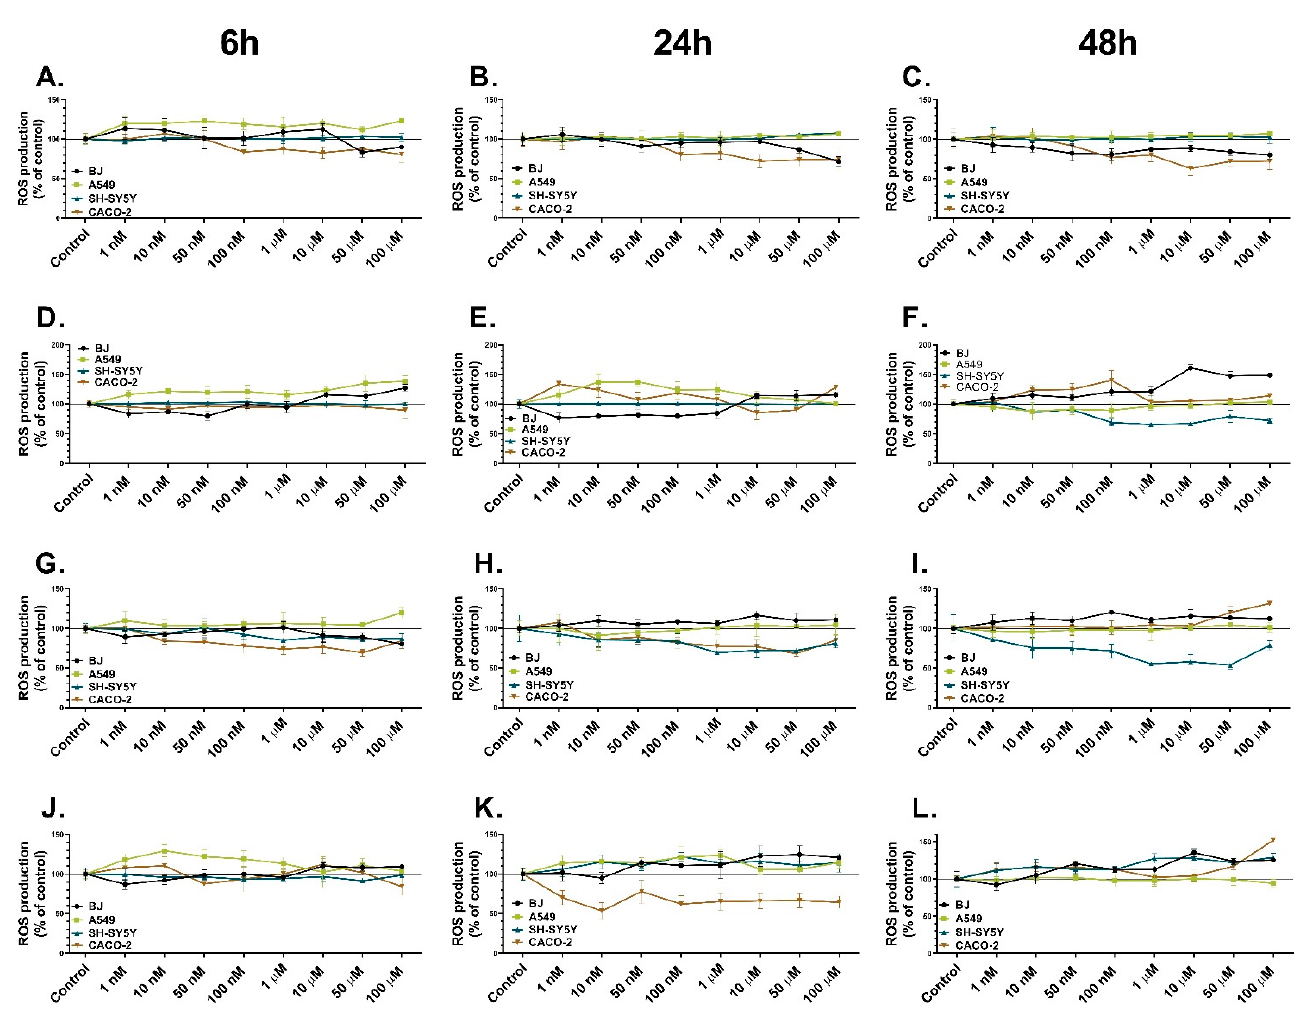
Figure 3. ROS production in BJ, A549, SH-SY5Y, and CACO-2 cell lines after treatment with increasing concentrations of Les-3166 ( A – C ), Les-5935 ( D – F ), Les-6009 ( G – I ), and Les-6166 ( J – L ) after 6 h ( A , D , G , J ), 24 h ( B , E , H , K ), and 48 h ( C , F , I , L ). The statistical significance of each data point analyzed using one-way ANOVA is described in the Supplementary Data (Tables S1–S12).